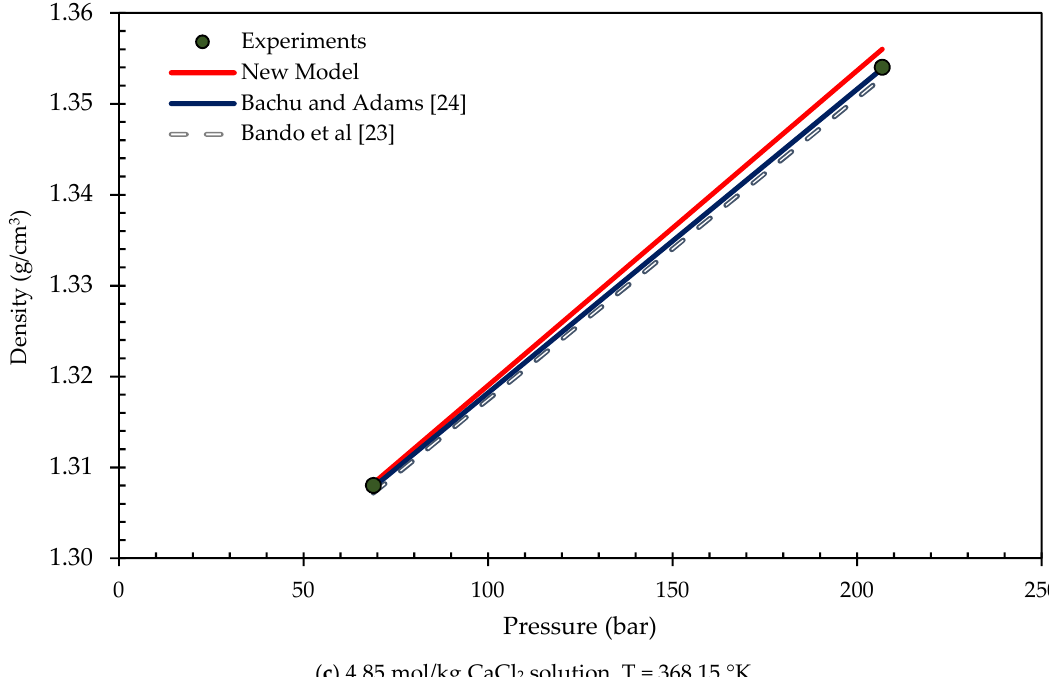
Figure 10. A comparison of experimental data and different model estimations for the density of a 4.85 mol/kg CaCl 2 solution saturated with CO 2 at ( a ) 328.15 °K, ( b ) 351.65 °K, and ( c ) 368.15 °K.